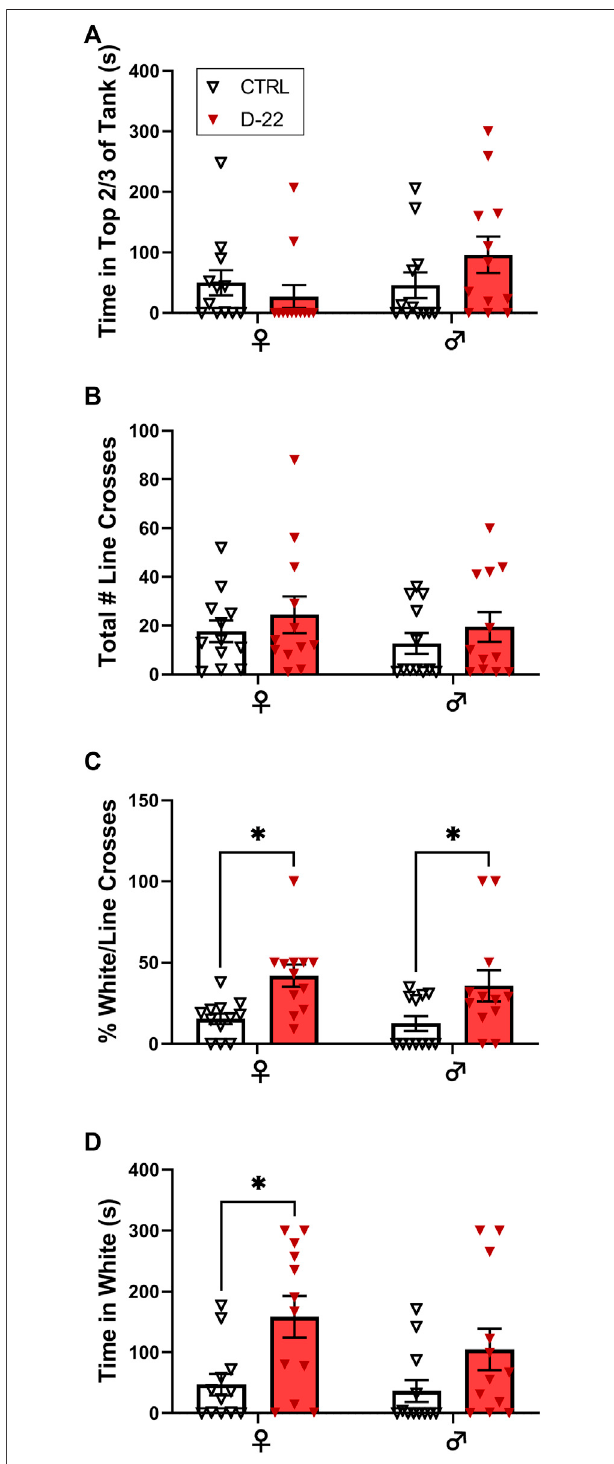
FIGURE 3 | Acute effects of D-22 (50 mg/L) on female versus male zebra fi sh in anxiety tests. A total of 48 zebra fi sh, 12 each of males and females, were treated with D-22 or a vehicle control for 5 min, washed for 5 min, and tested in a battery of anxiety-relevant behaviors. (A) There